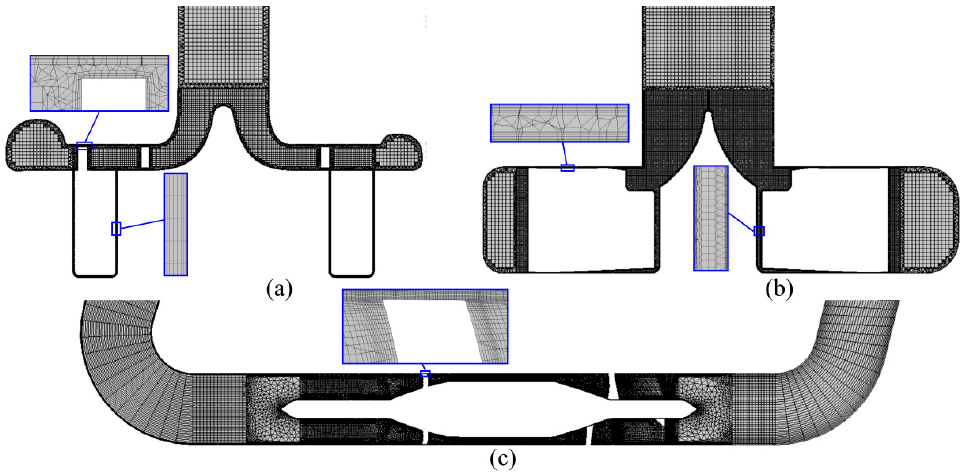
Figure 3. Mesh of the studied VADs: ( a ) CH-VAD; ( b ) HVAD; and ( c ) HM II.